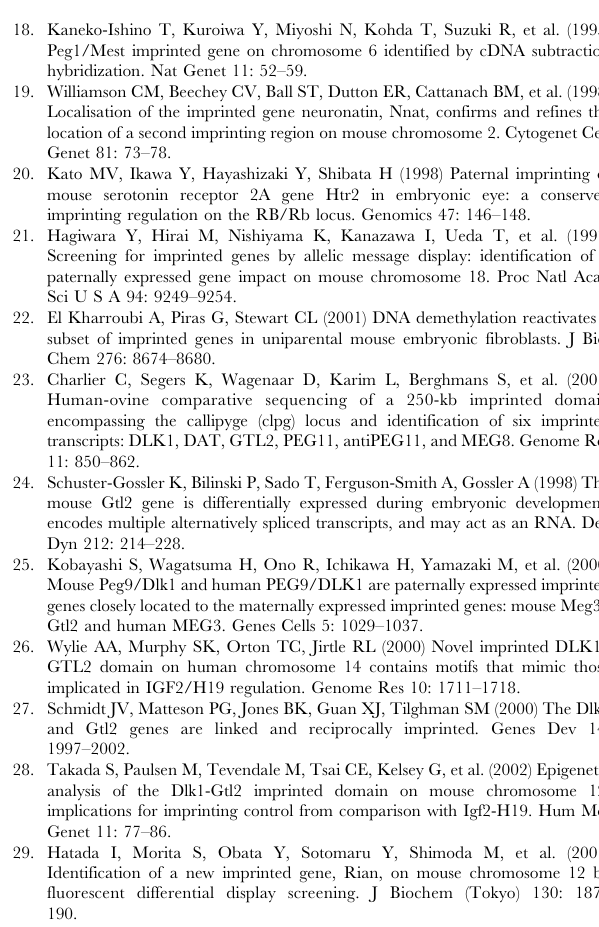
Table S2 Restriction site polymorphisms in cDNAs